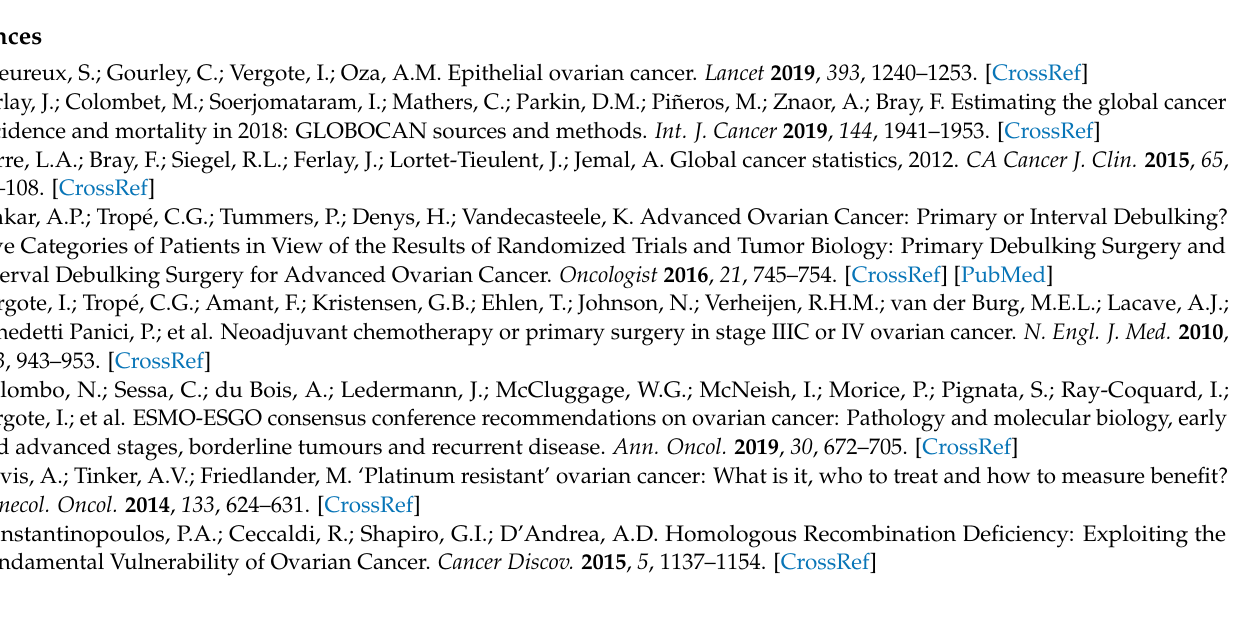
Table S1: Summary of data collected for surgical management and systemic therapy of recruited patients. Table S2: Univariable and multivariable logistic regression analysis for the association of first- line treatment (platinum-based chemotherapy + bevacizumab versus platinum-based chemotherapy only) with factors of